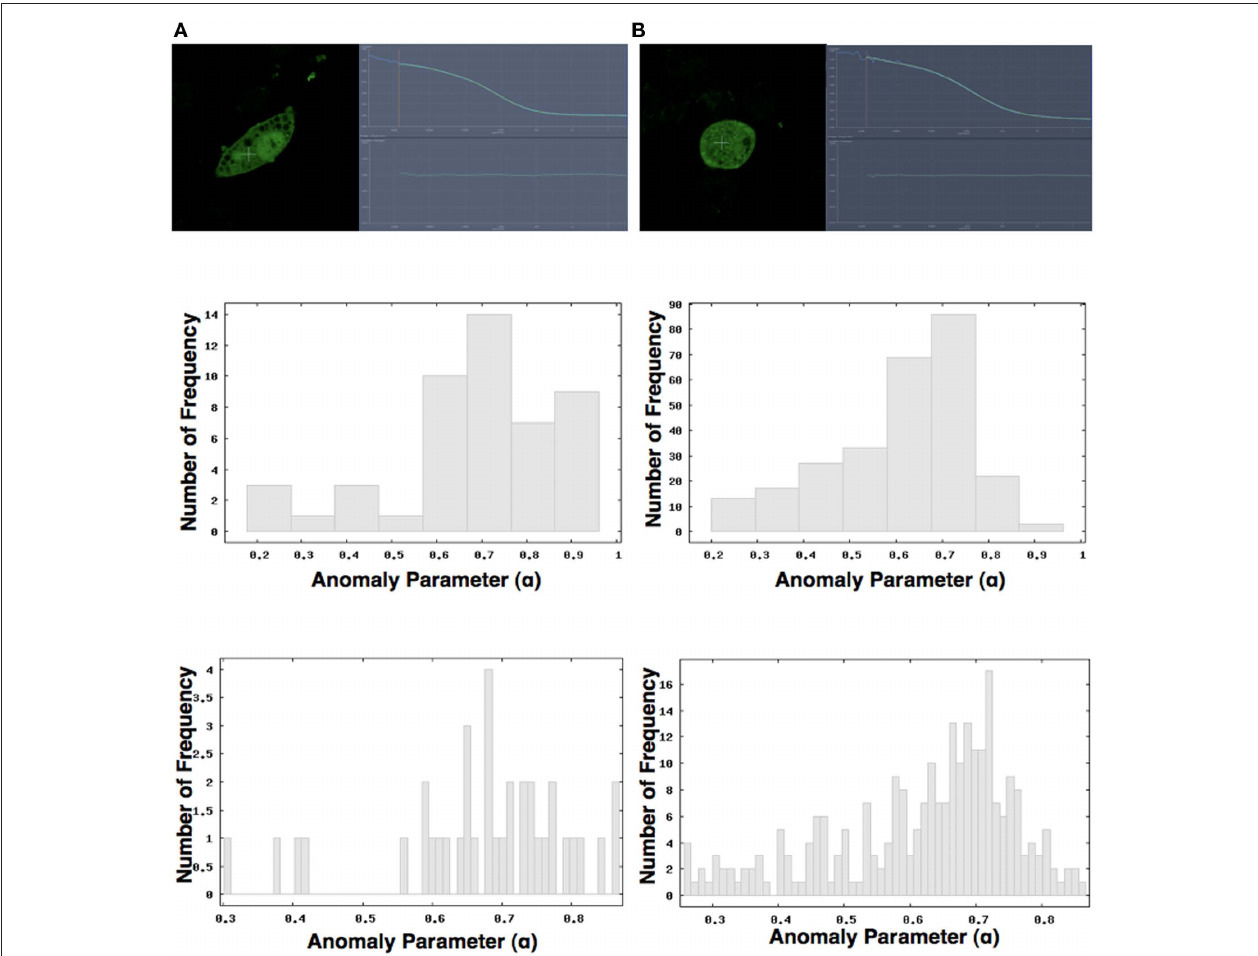
FiguRe A2 | Fluorescence correlation spectroscopy analysis with colchicine treated cells (A). FCS analysis with control cells (EtOH treated). The top left panel is the image of a control cell, and the right panel is the example data of auto-correlation curve of FCS analysis. The histogram indicated in the middle panel shows the distribution of the value of anomalous parameter of control cells in eight ranges between 0.2 and 1. The bottom histogram indicates the distribution of the value of anomalous parameter of control cells in 55 ranges between 0.3 and 1 to show the mode value among the data clearly. (B)